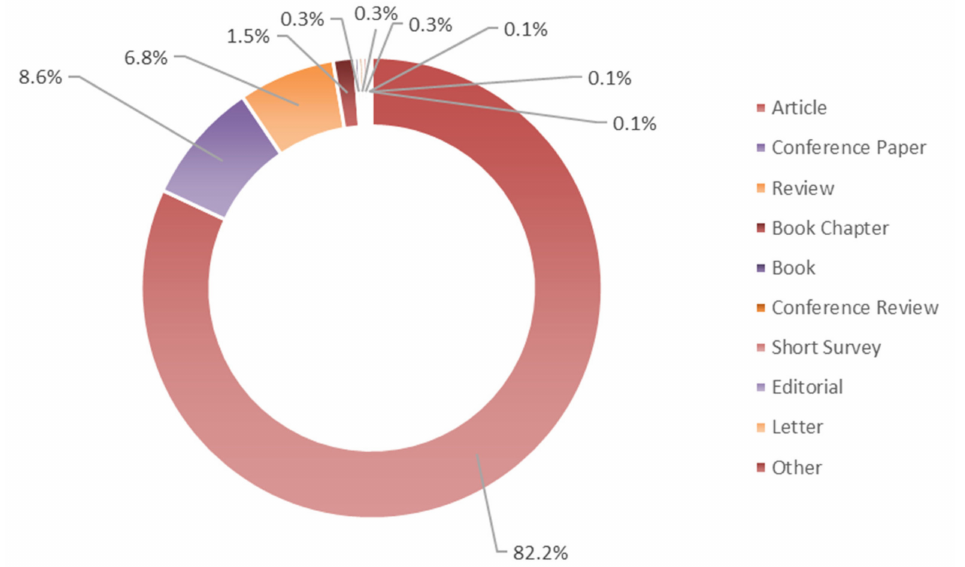
Figure 2. Distribution of documents by type (Bibliometric data were extracted from the Scopus online